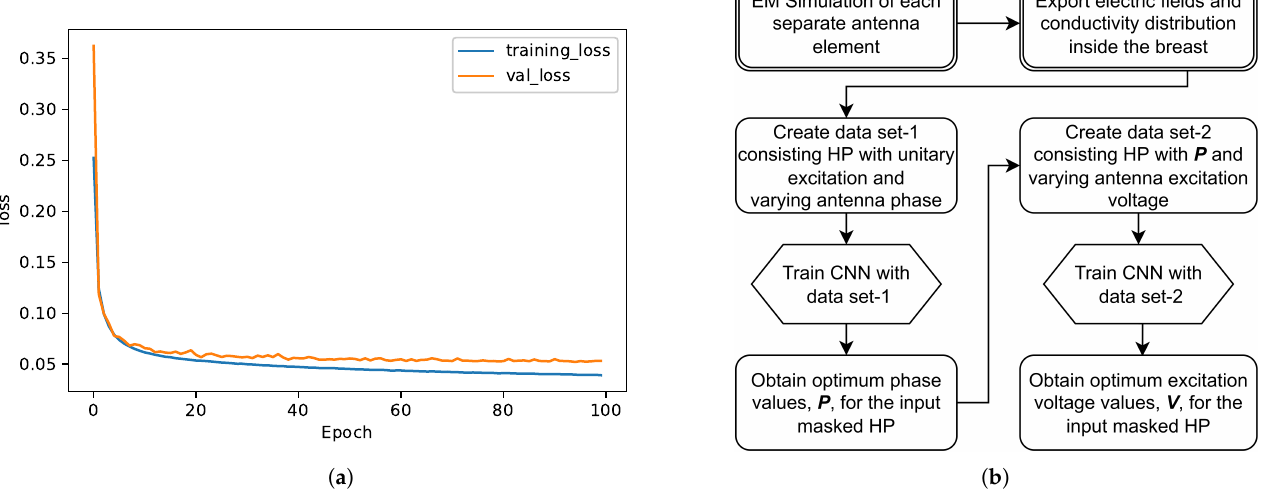
Figure 3. ( a ) Training and validation loss with increasing epoch. ( b ) System flowchart. The exact HP distribution in the breast medium is unknown. To represent the desired HP in the breast medium, a masked HP input was generated. The masked input contains a square region with a 10 mm side length centered at the target point. The target point location coincides with the tumor center if the handled case has a tumor. Since the goal is to maximize the HP on the target and minimize it in the healthy tissue, the value of the square and the remaining region were assigned as 1 and 0, respectively. This masked HP distribution was used as the input to both trained CNN-1 and CNN-2 models, and the outputs were the sine and cosine of the excitation phases for CNN-1 and excitation voltages for CNN-2. Note that the outputs are not necessarily from the data set; since we used CNN for regression, the outputs can take any value within the acceptable range. Obtained excitation voltage levels were then converted to power for